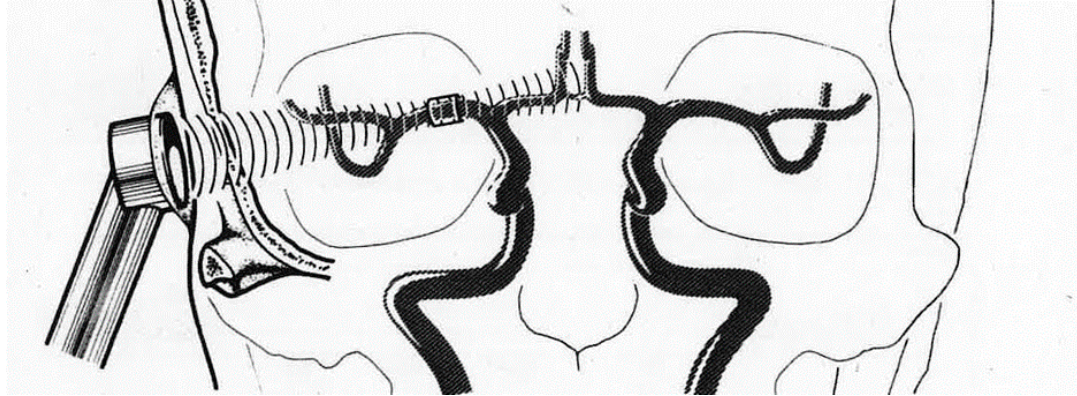
Figure 5. Measurement of blood flow velocity in the middle cerebral artery by transcranial Doppler